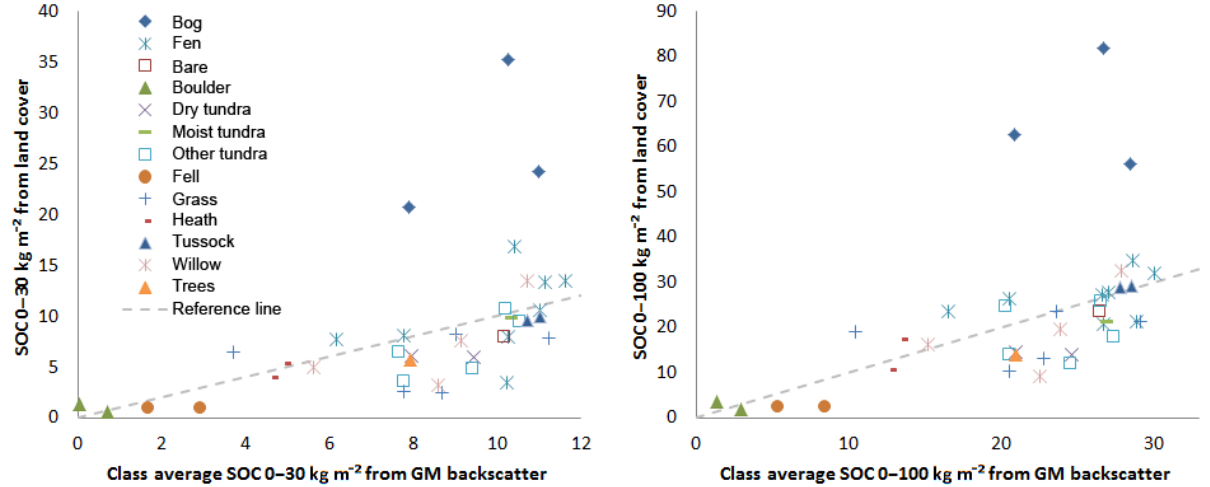
Figure 9. SOC from land cover classifications (all sites: Kytalik, Zackenberg, Tulemalu, Shalaurovo and Arymas) vs. SOC from ENVISAT ASAR GM, by land cover (harmonized classes) and depth: left, 0–30cm; right,